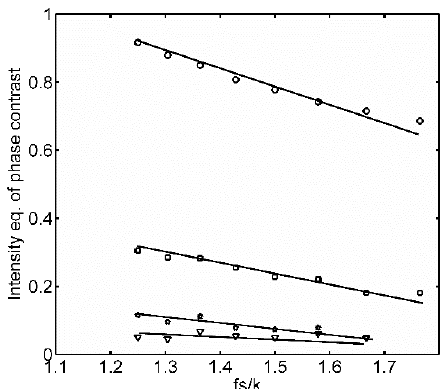
Figure 7 . Intensity equivalent of phase contrast versus f s / k ratio for ∅ = 15 mm defects: circles, squares, pentagrams and triangles along vertical B, C, D and E, respectively.